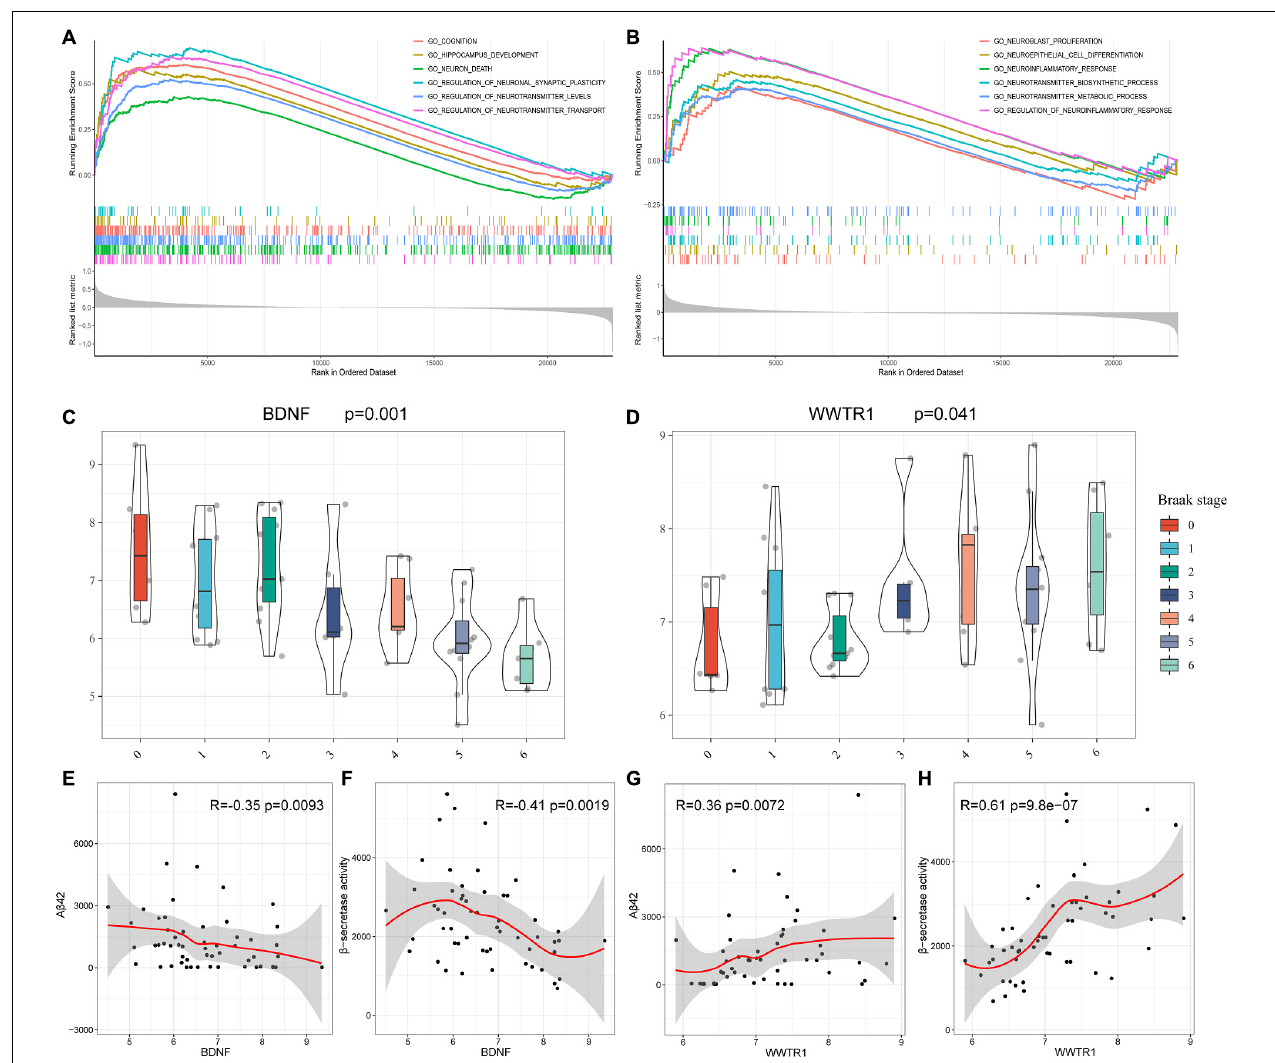
FIGURE 8 | GSEA based on GSE48350 and independent validation analysis based on GSE106241. (A) BDNF. (B) WWTR1. (C) BDNF expression levels in the Braak stages 0–6. (D) WWTR1 expression levels in Braak stages 0–6. (E) Correlation between BDNF and A β 42 levels. (F) Correlation between BDNF and β -secretase activity. (G) Correlation between WWTR1 and A β 42 levels. (H) Correlation between WWTR1 and β -secretase activity. p -values < 0.05 were considered to be statistically